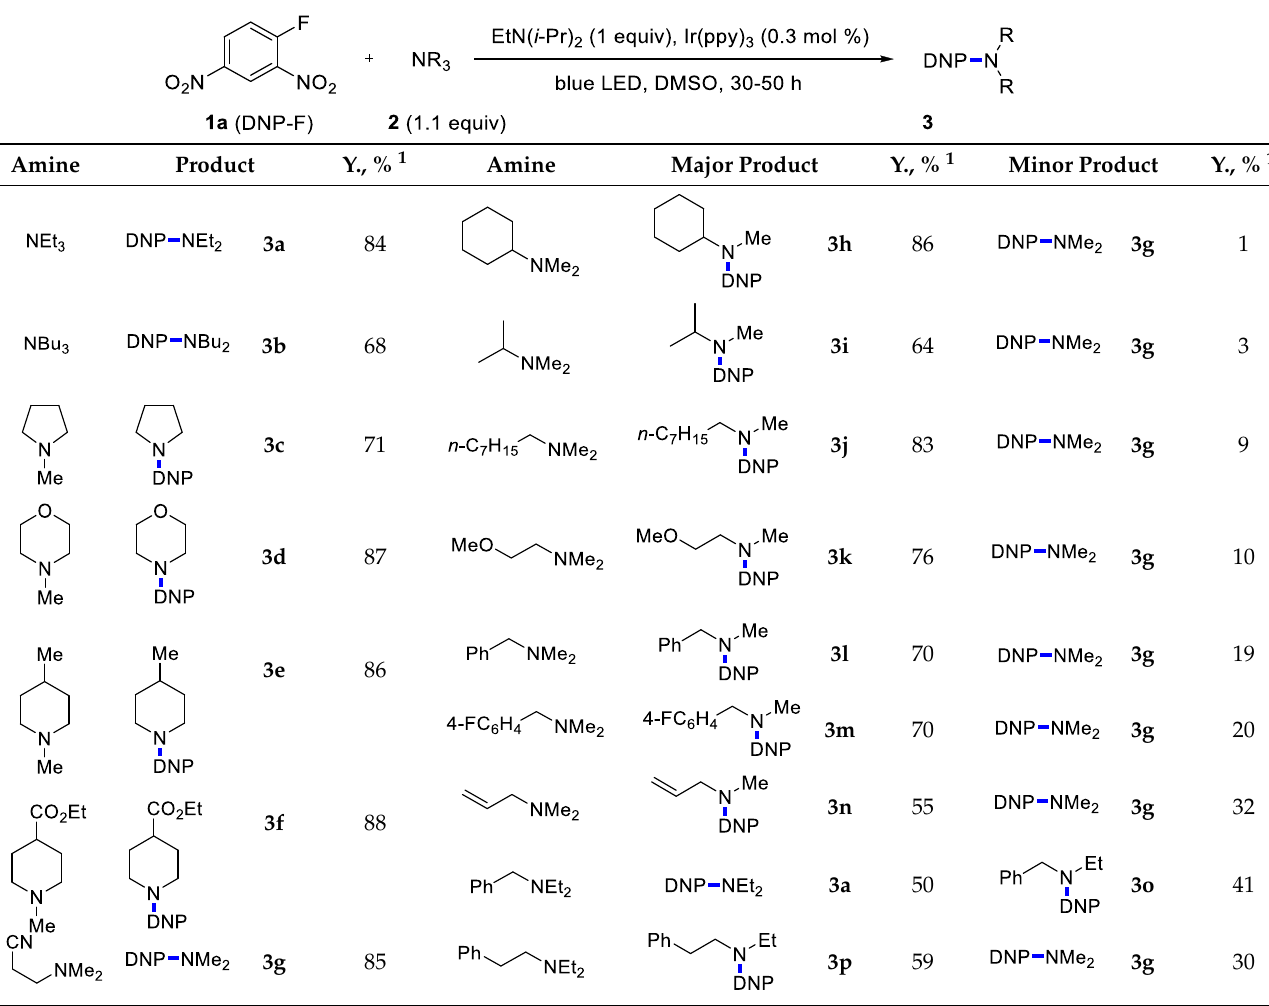
Table 2. Reaction of fluoride 1a with amines.